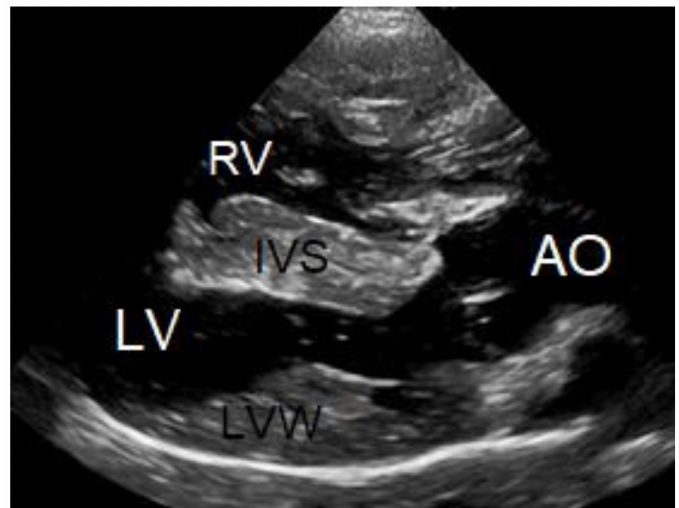
Figure 5. Two-dimensional long axis echocardiographic image from the standard right parasternal long-axis view at 3 years of age shows a positive bubble study, i.e., the appearance of air bubbles, displayed as echogenic dots in the lumen of the left ventricle (LV) after an intravenous injection of 5 ml agitated physiologic saline solution. RV—right ventricle, AO—aorta, IVS—interventricular septum, LVW—left ventricular free wall.